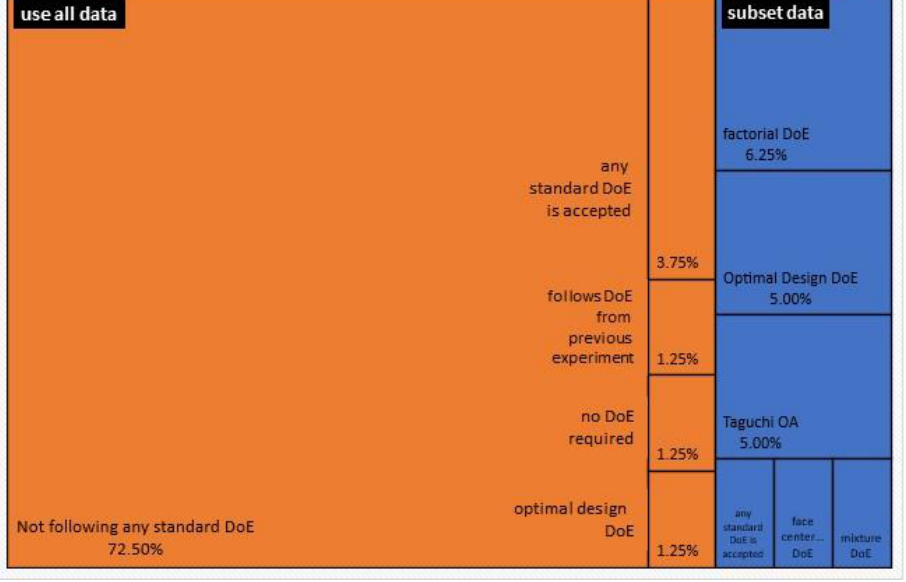
Figure 10. DoE stage.